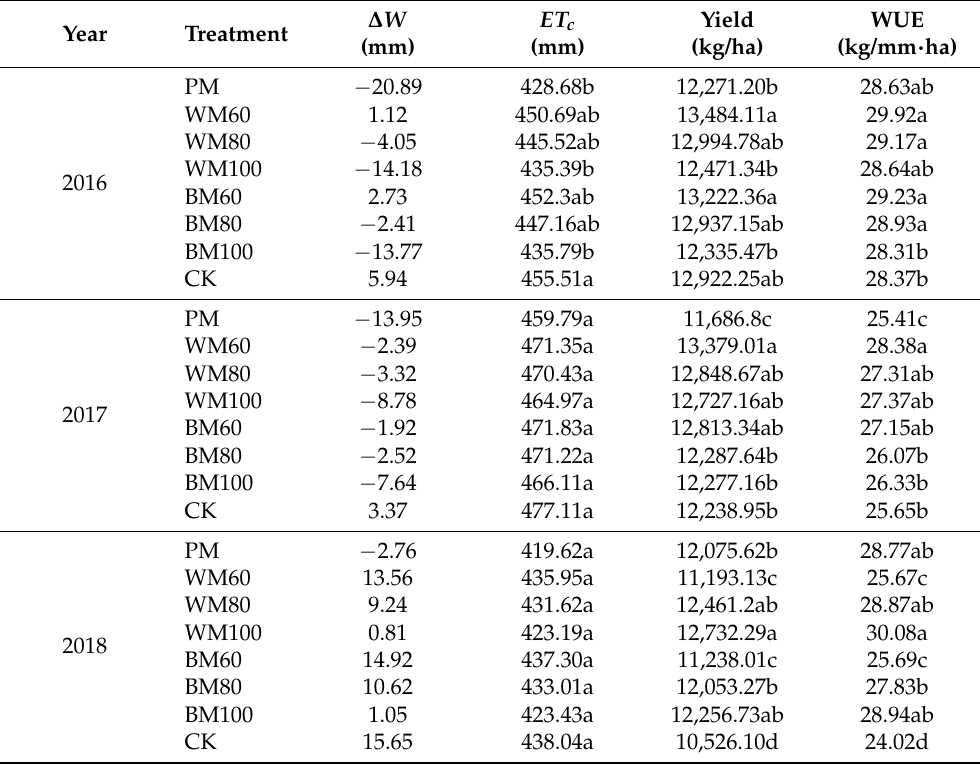
Table 1. Effects of different film mulching on yield and water use efficiency (WUE) of maize. Year Treatment